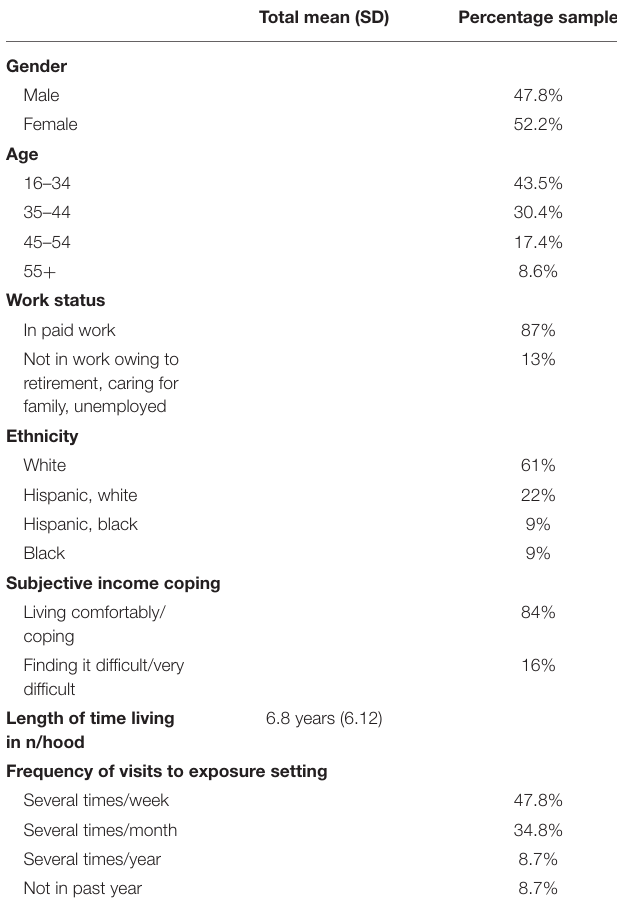
TABLE 1 | Characteristics of the study population, n = 23.